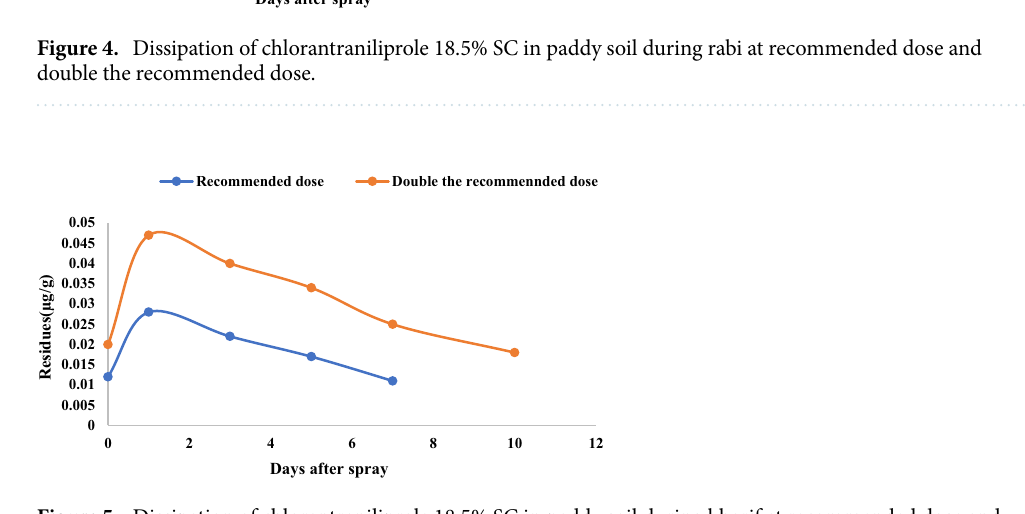
Figure 5. Dissipation of chlorantraniliprole 18.5% SC in paddy soil during kharif at recommended dose and double the recommended dose.